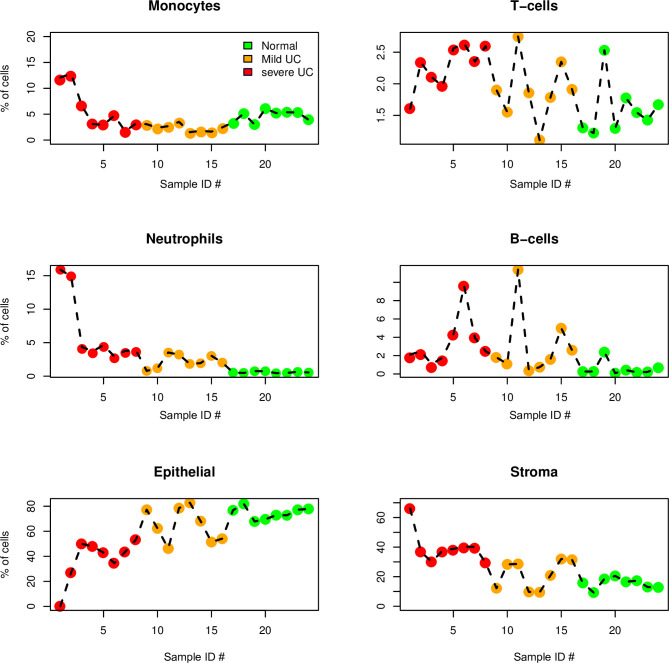
Cell fraction estimation between samples using cell deconvolution algorithm absolute deconvolution of human immune cell types.The fractions of different cell populations in severe and mild UC and control tissue samples were estimated from gene expression data, using absolute cell deconvolution as described in Materials and Methods. The deconvolutions were solved for the following cell types: epithelial cells, monocytes, T cells, neutrophils, B cells, and stroma cells. Each panel shows the estimated percentage of the indicated cell types (y-axis) across all 24 samples sorted according to sample ID numbers (y-axis). For ease of comparison, sample ID numbers are identical to those shown in PCA of methylation and gene expression data (Fig 1). Plot markers are colour coded according to sample group. The fractions of epithelial and stromal cells were estimated from the non-immune cell remainder and the expression levels of the stromal and epithelial marker genes. The epithelial markers (EPCAM, CDH1, CDH17 and CDH18) and stroma markers (ENG, THY1, ACTA2 and COL2A1) were used. Severe UC is indicated by red dots, mild UC is indicated by orange dots, and control is indicated by green dots. Statistical comparison of cell population estimates can be found in S4 Table.